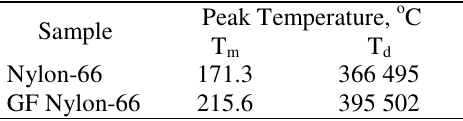
Table 7. Thermal transition of